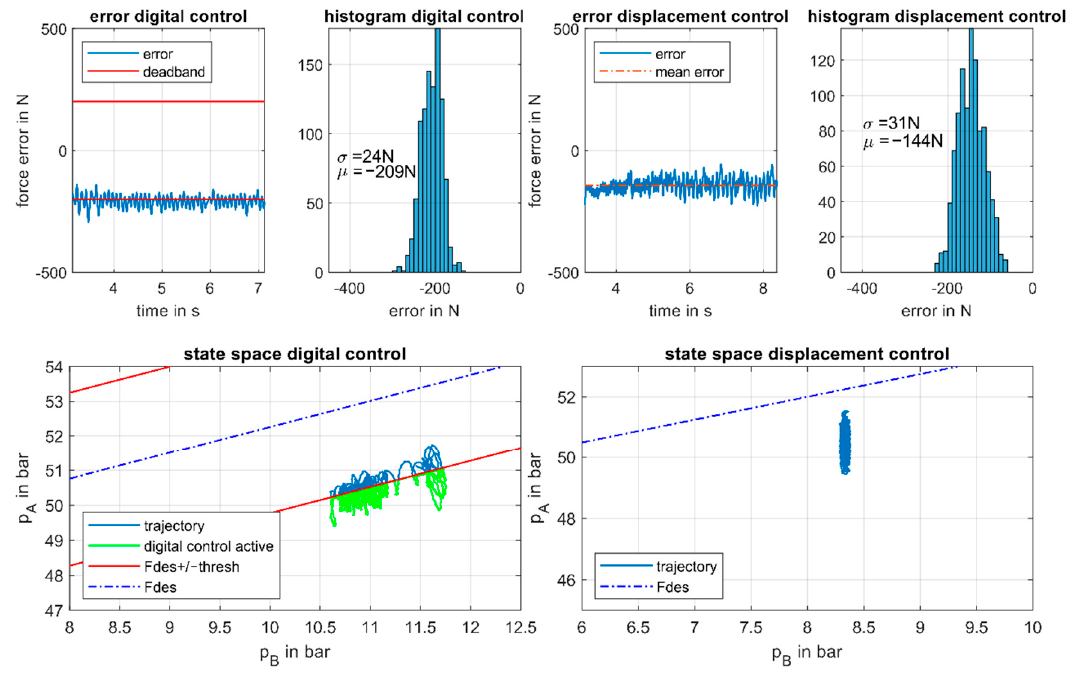
Figure 6. Control error and state space representation of pressures in the working cylinder for digital control ( left column ) and displacement control ( right column ).